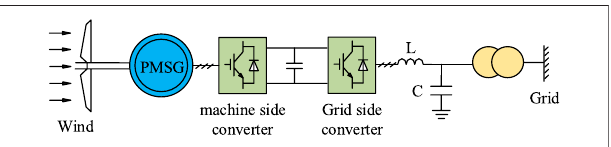
FIGURE 2 | Permanent magnet direct drive wind